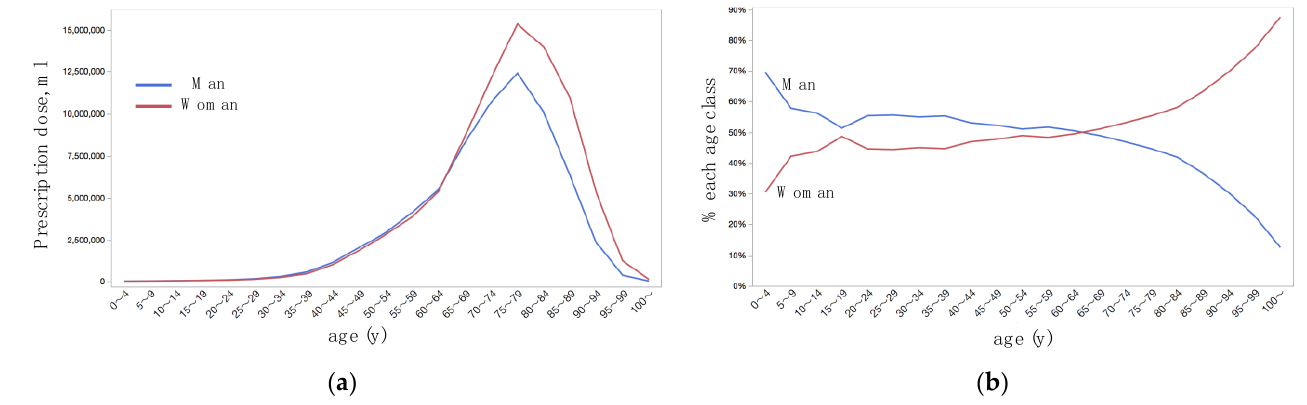
Single. single medication formulation; FDC, fixed-dose combination; Brand, brand-name medica- tion; * interaction between two variables. tion; * interaction between two variables.